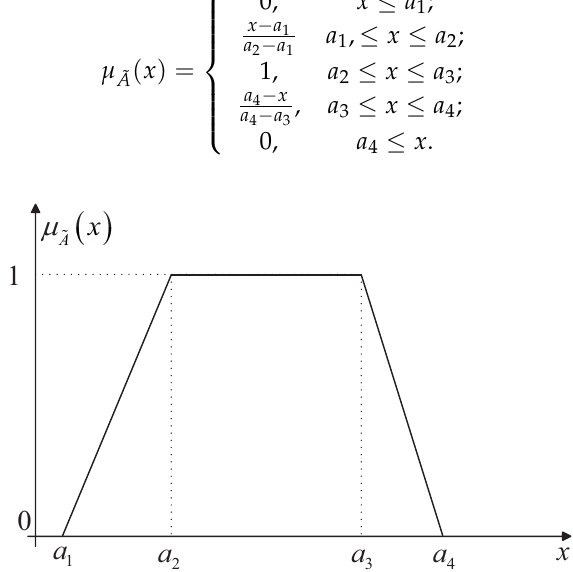
Figure 1. Graphically presentation of the trapezoidal fuzzy number.